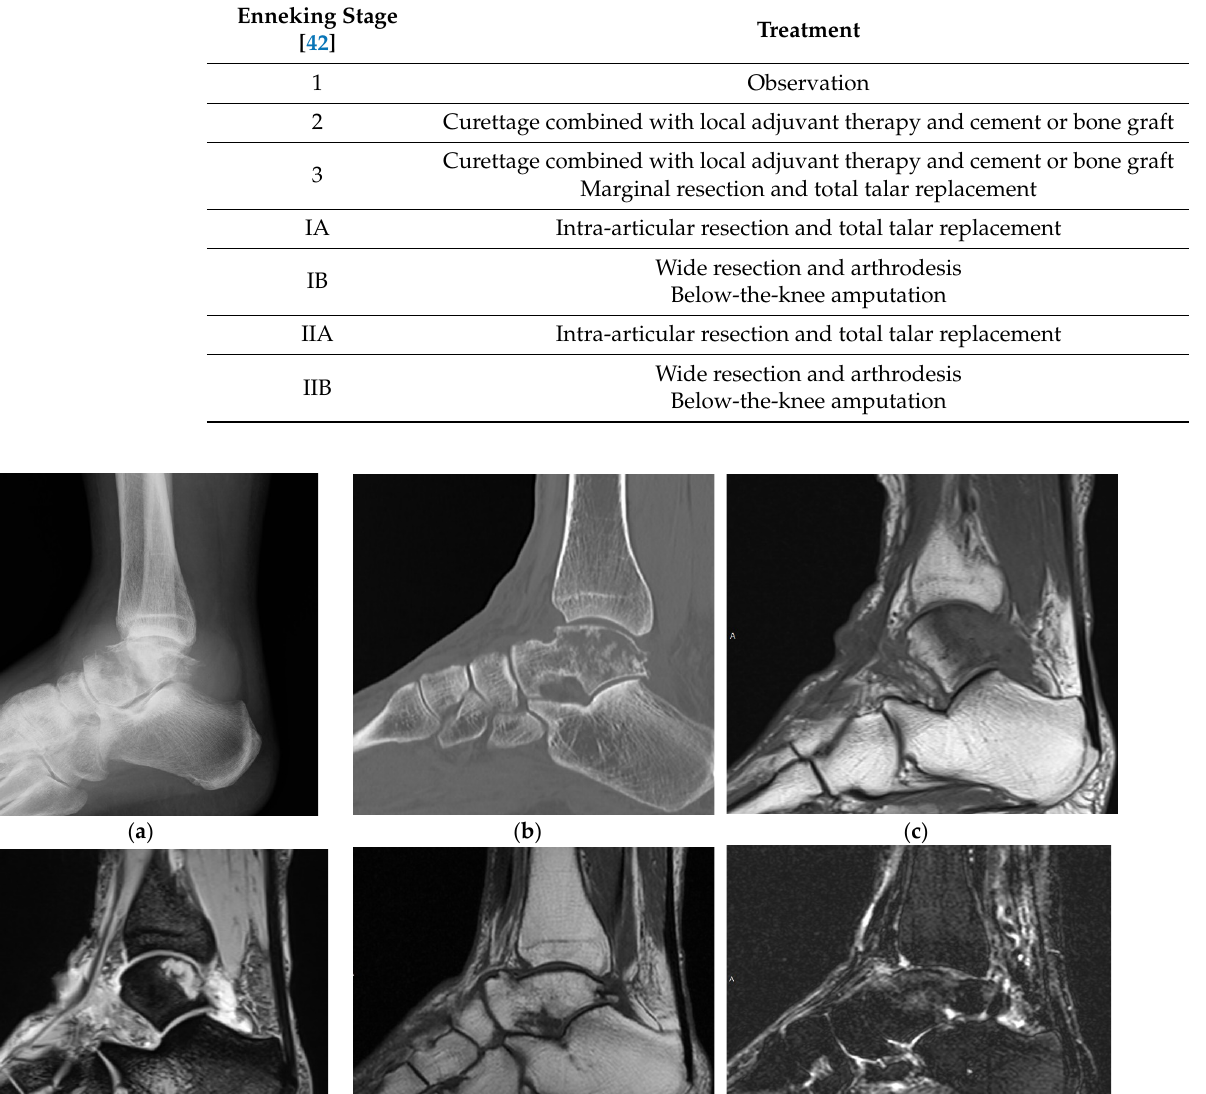
Table 4. Treatment strategy for talar tumors.